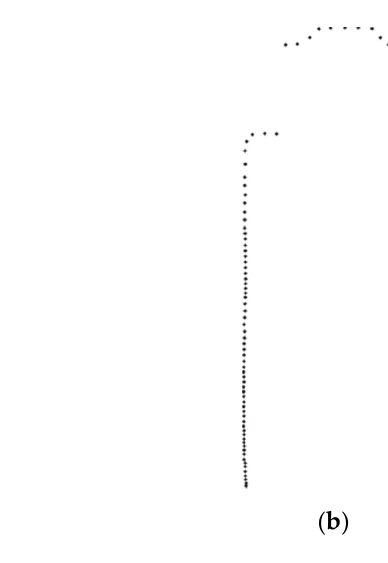
Figure 5. ( a ) Resampling process in grid form; ( b ) resampled point clouds.